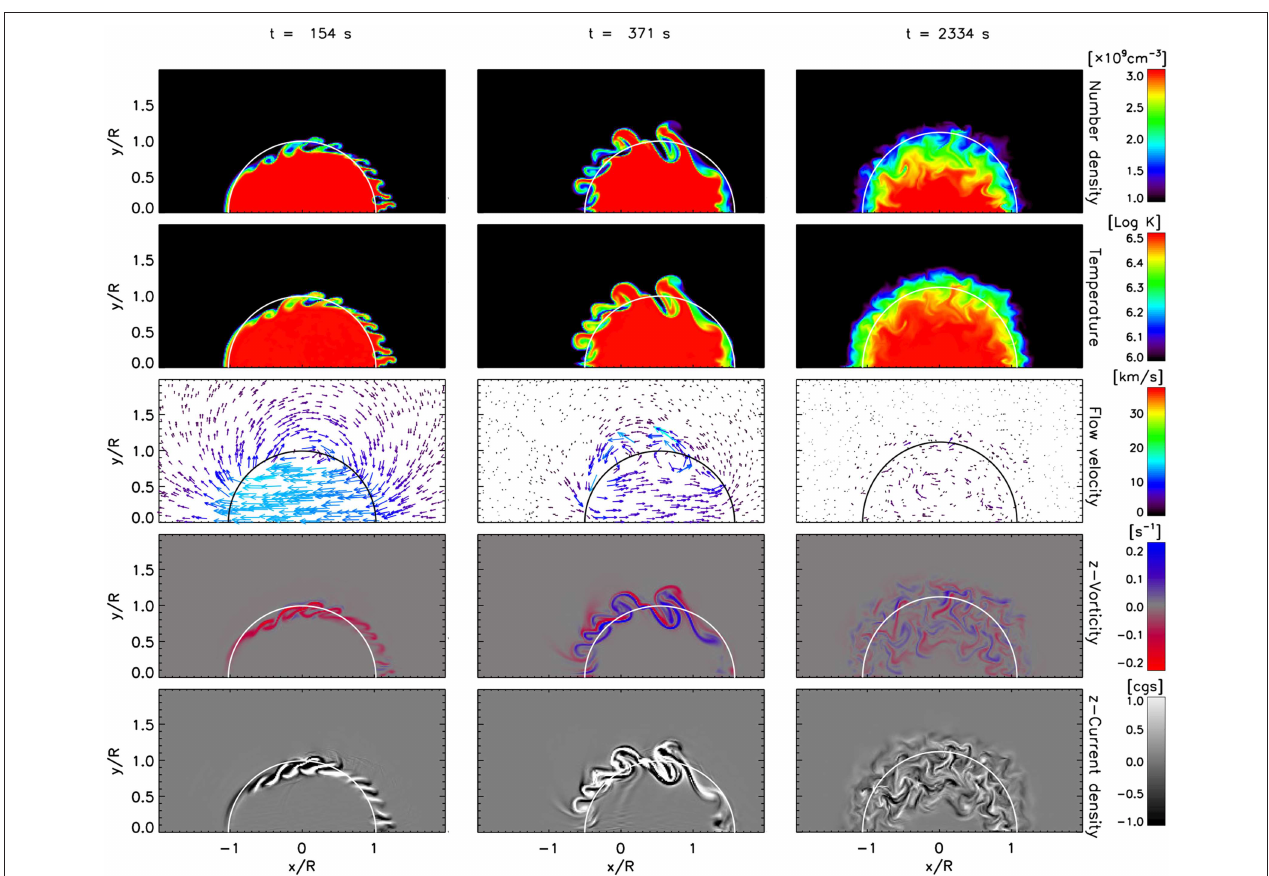
vorticity component (in s − 1 ) and − P / 2, t 154 s 371 s 1.2 P , and = ≈ = ≈